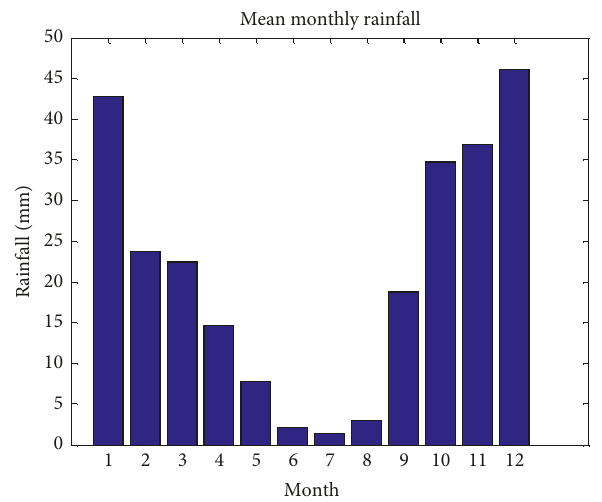
Figure 9: Histogram of the mean monthly rainfall in Fucino,